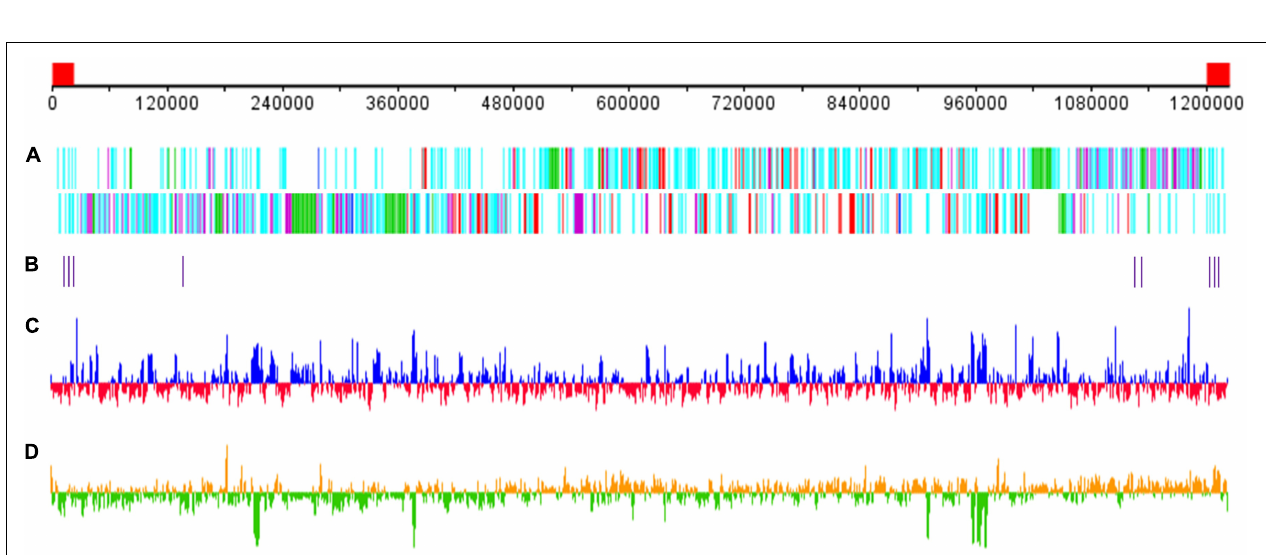
Frontiers in Microbiology |